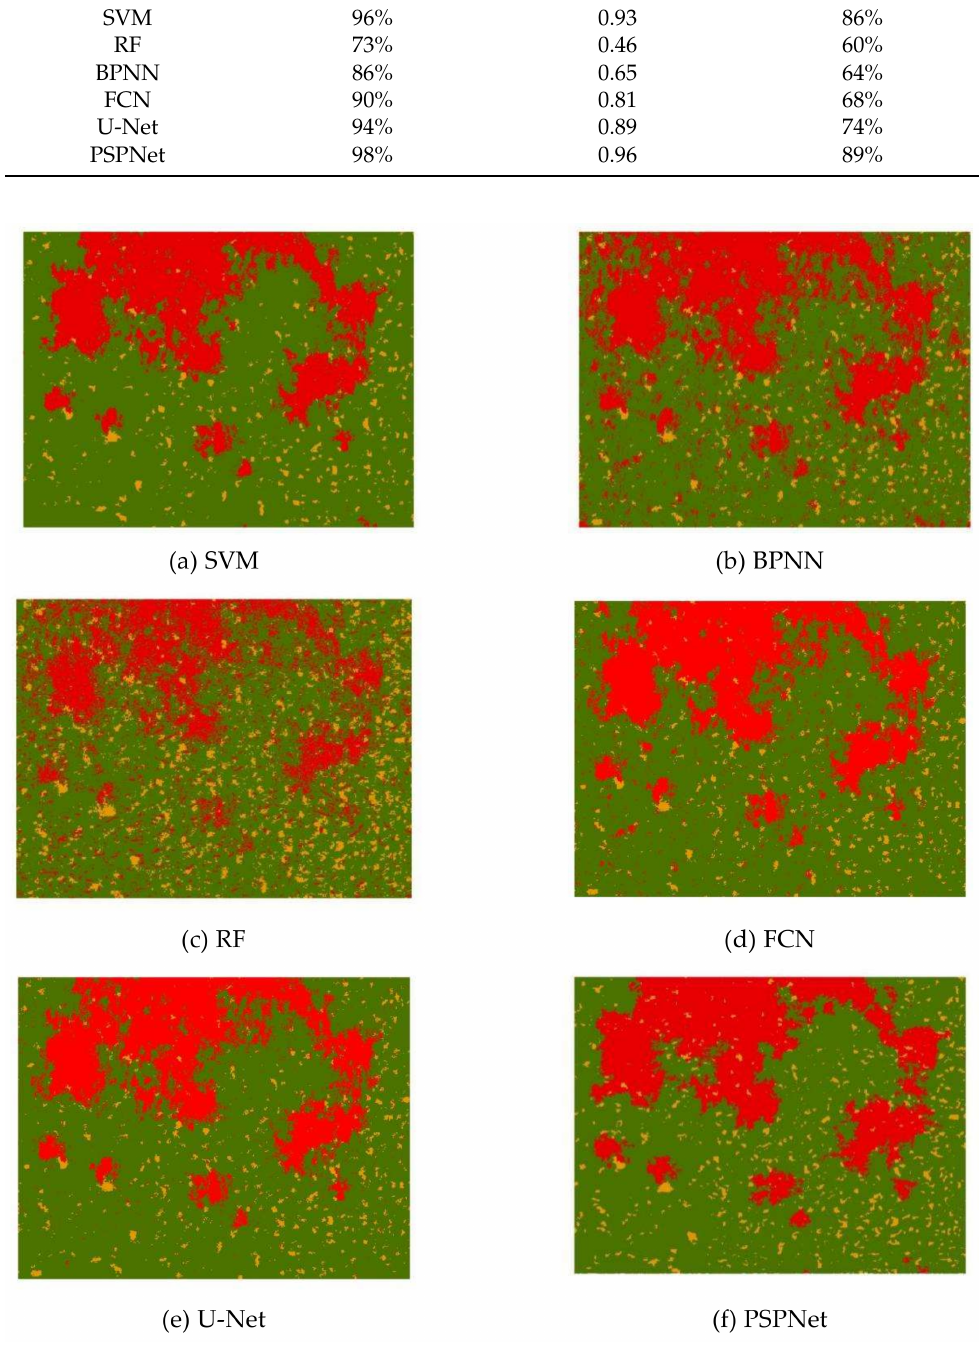
Figure 6. Predicted outputs of the ( a ) SVM, ( b ) BPNN, ( c ) RF, ( d ) FCN, ( e ) U-Net and ( f ) PSPNet